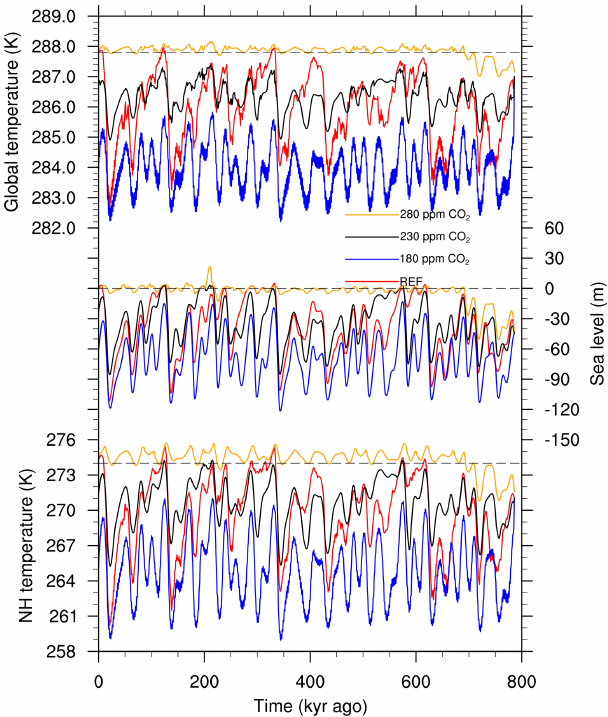
Figure 11. Modelled global temperature (top), sea level relative to PD (middle), and NH temperature (bottom) for the fully cou- pled reference run (red), a run with insolation fixed at PD value (blue) and a run with insolation fixed at the precession maximum of 125kyr ago value (black).